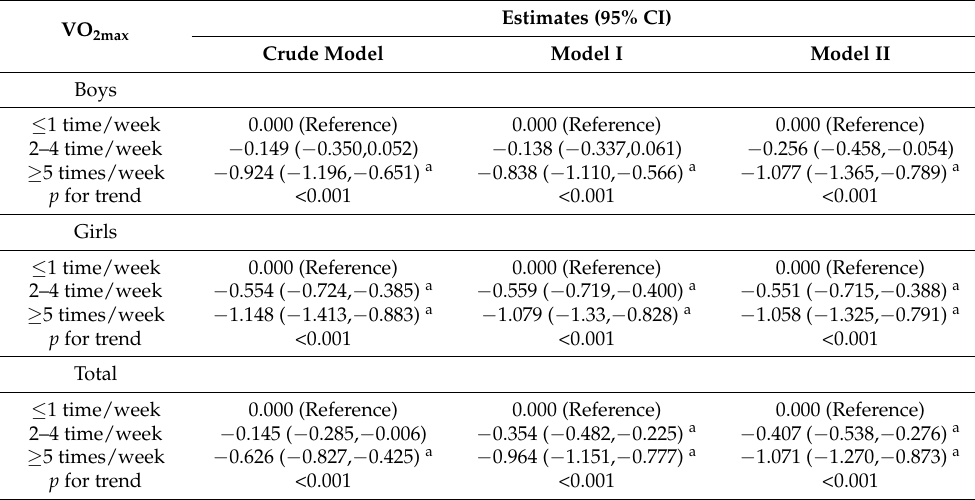
Table 4. Multiple linear regression analysis of VO 2max in children with different SSB consumption in China (n = 21,055).